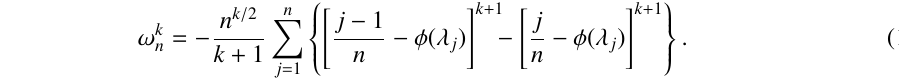
Figure 4. [Color online] The squared mass of charged particles from the background events as a function of the particle